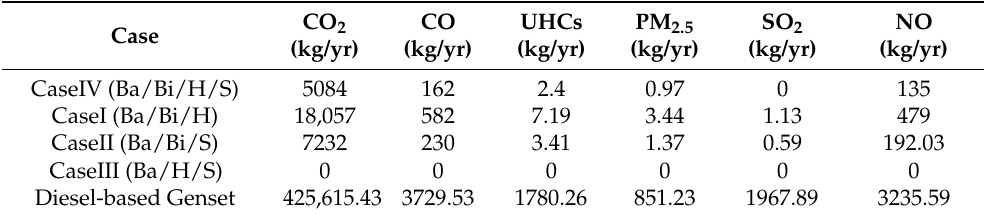
Table 4. Comparative representation of emissions from all the cases along with diesel-based generator supply